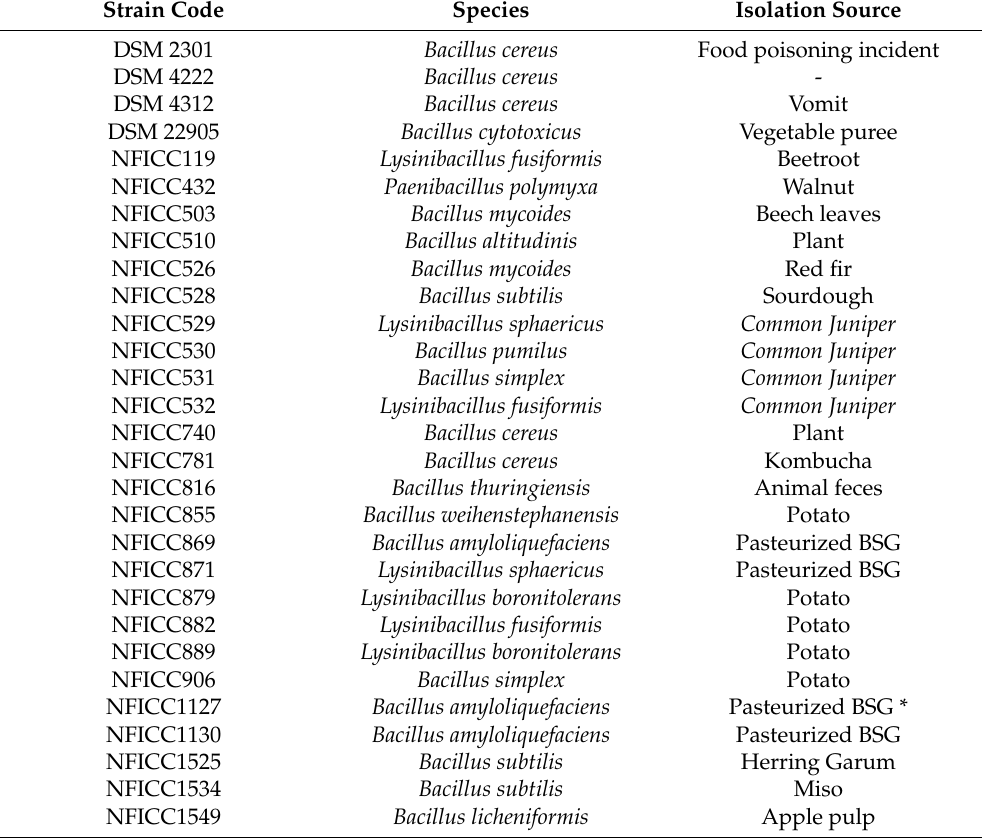
Table 2. Selected bread spoilage bacteria tested in the present study. They were provided by the German Collection of Microorganisms and Cell Cultures (DSMZ) and the National Food Institute Culture Collection